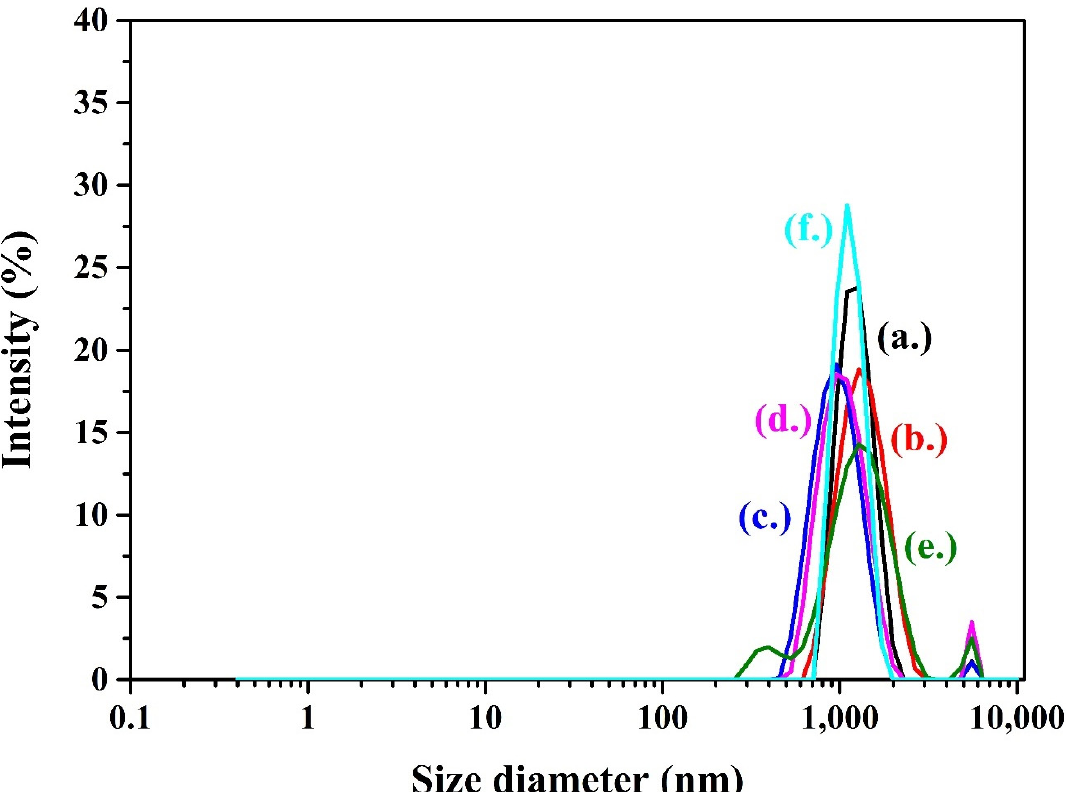
Figure 6. Size diameter analysis by dynamic light scattering (DLS) of biphasic calcium phosphate prepared by cuttlebone with variation of the CMC of L-rhamnose monohydrate biosurfactant: ( a ) no CMC, ( b ) 10 CMC, ( c ) 20 CMC, ( d ) 100 CMC, ( e ) 500 CMC and ( f ) 1000 CMC.